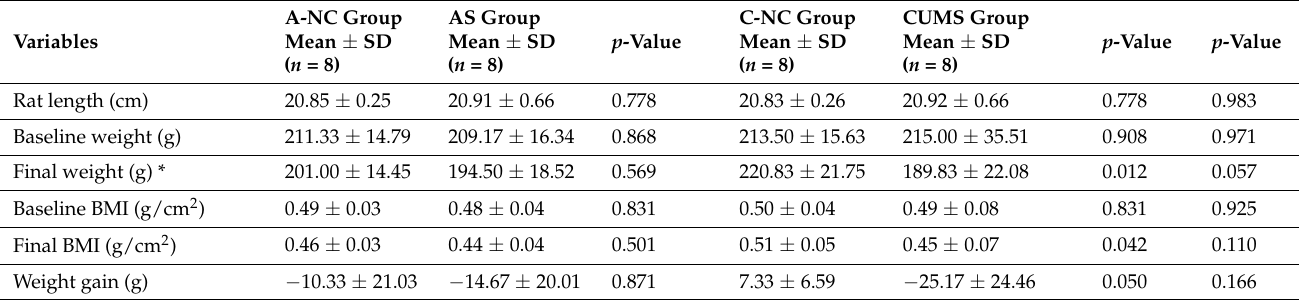
Table 2. Body weight changes among study groups.